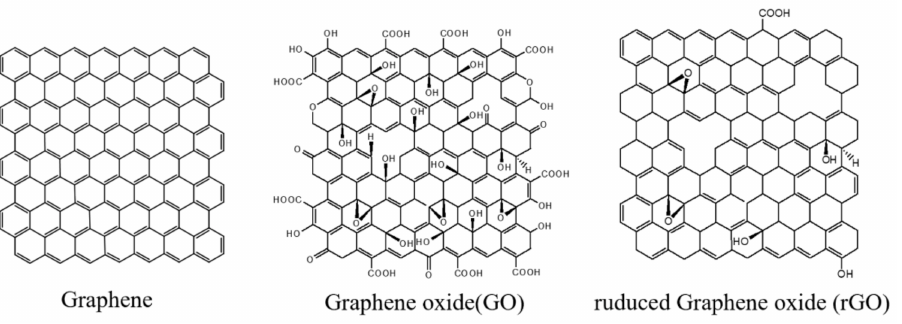
Figure 5. Schematic diagram of GBNs.